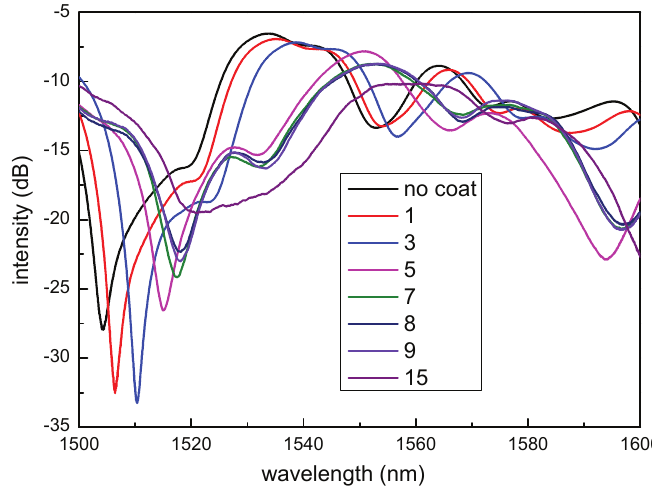
Figure 3. Transmission spectra of the sensor coated by 0.05 wt/vol % agarose solution in different coating numbers.